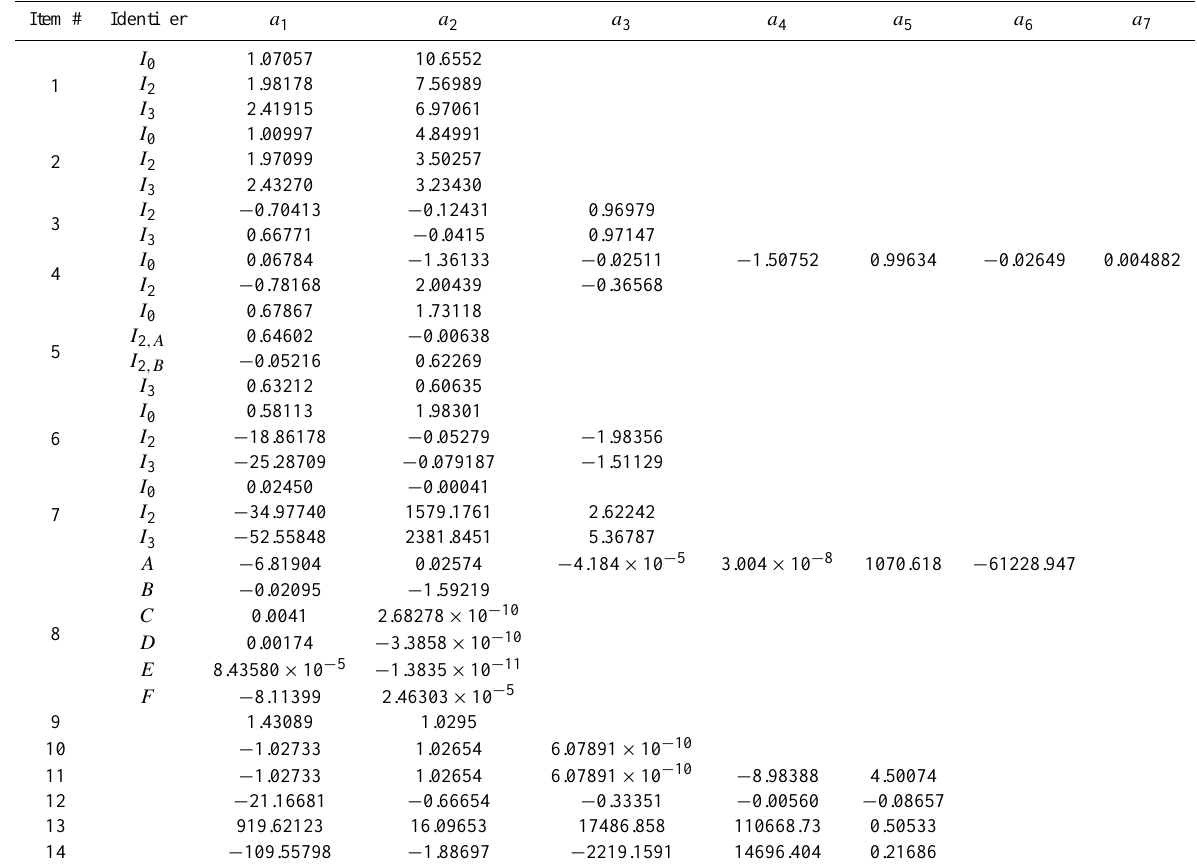
Table A2. Coefficients for SNAP